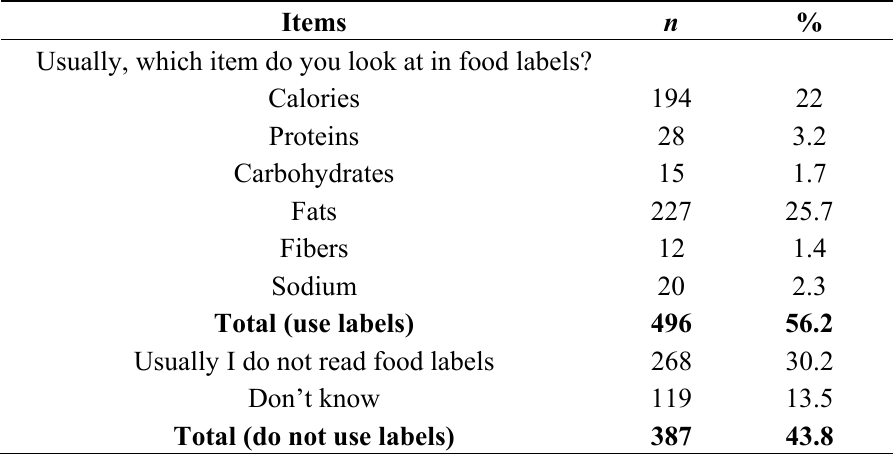
Table 2. Attention to food labels’ single